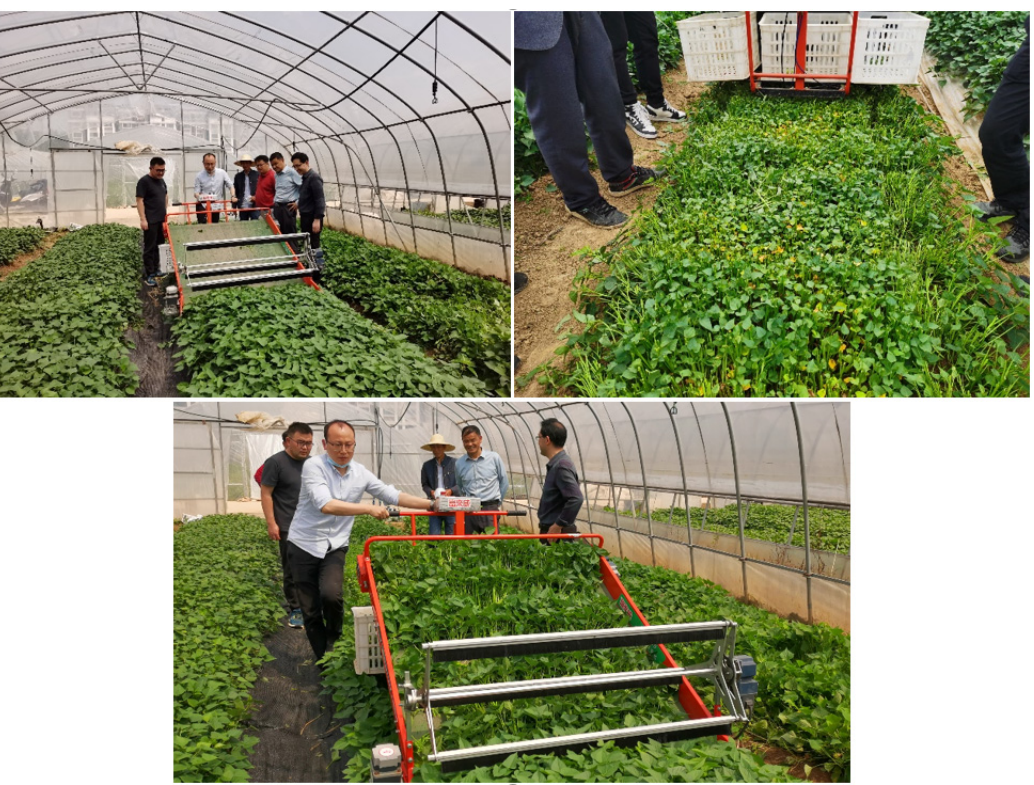
Figure 17. Photographs of the 4UM-120D electric leafy vegetable harvester in the field.